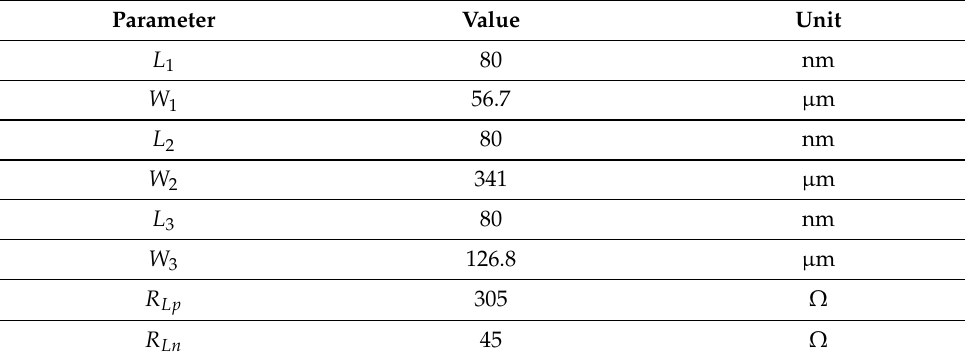
Table 4. Circuit sizing of the second design example.